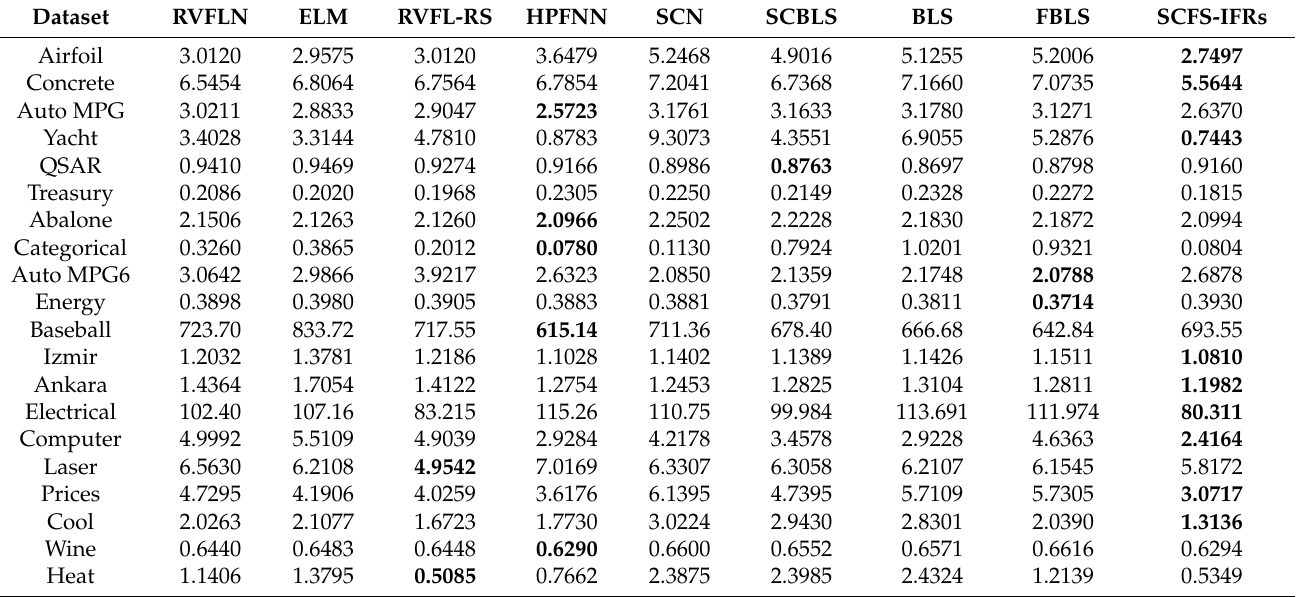
Table 4. Comparisons of testing RMSE on 20